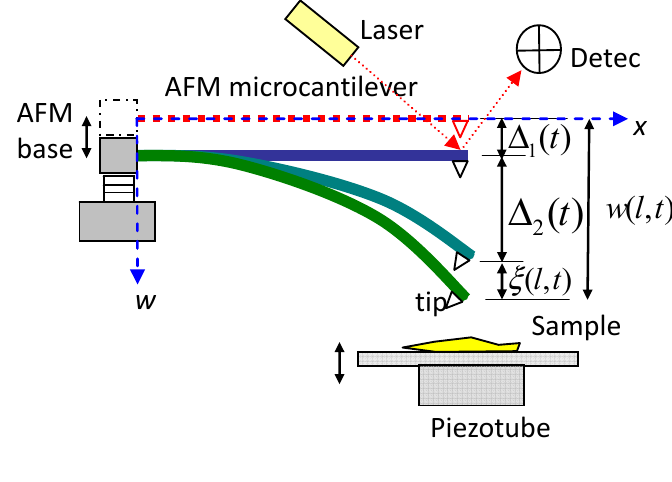
(t) denotes elevation of 1